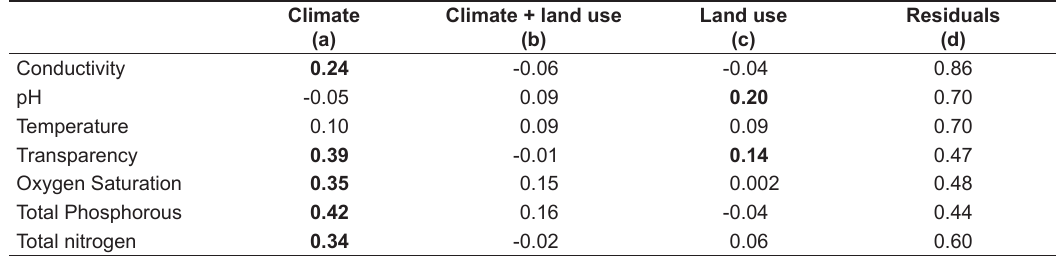
Table 2. The importance relative (measured by R 2 ) of climate and land use for each individual limnological variable. Partial components are (a) purely climate, (b) shared between climate and land use, (c) purely land use, and (d) residual. Numbers in boldface indicate P <0.05. The significance for the b and d components cannot be tested. No spatial autocorrelation in residual of regressions was found ( P values greater than